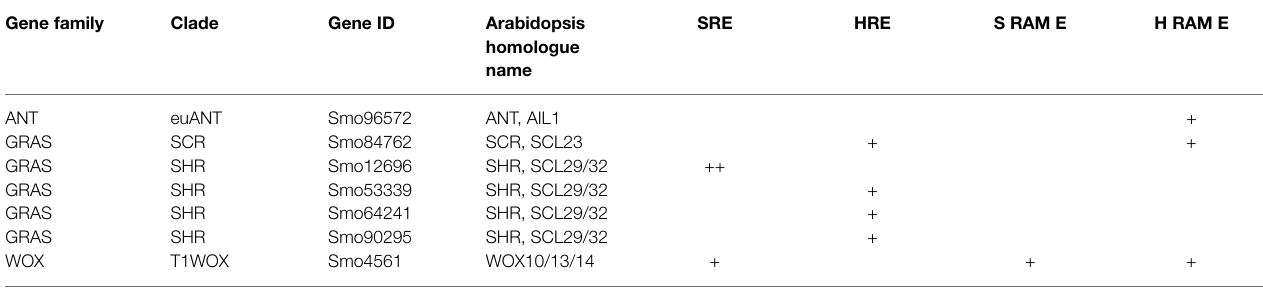
TABLE 2 | Specific and high root and RAM expression of the developmental genes in S. moellendorffii . Gene family Clade Gene ID Arabidopsis